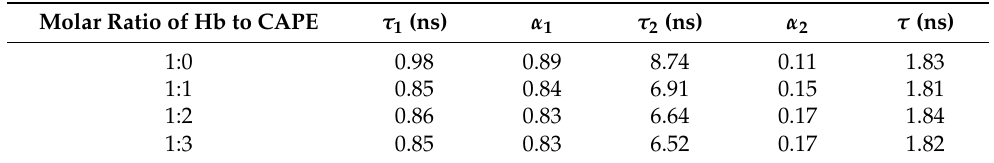
Table 2. Fluorescence lifetimes at different molar ratios of Hb and CAPE at 298.2 K and in pH 7.4 phosphate